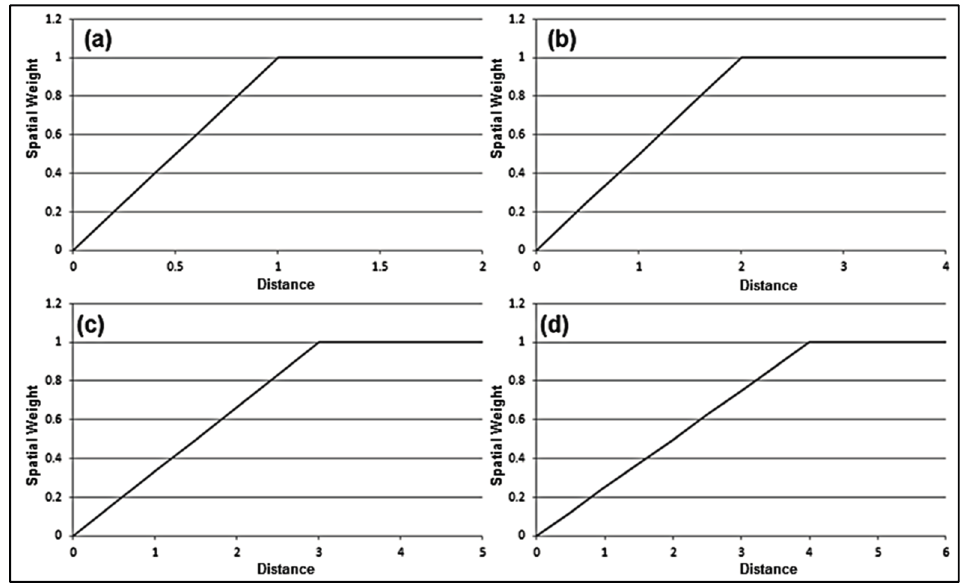
Figure 5. Spatial weights calculated from the distance, in pixel units, between a pixel and the nearest segment boundary. Weighting schemes 1–4 (W1–W4) are shown in ( a – d ),